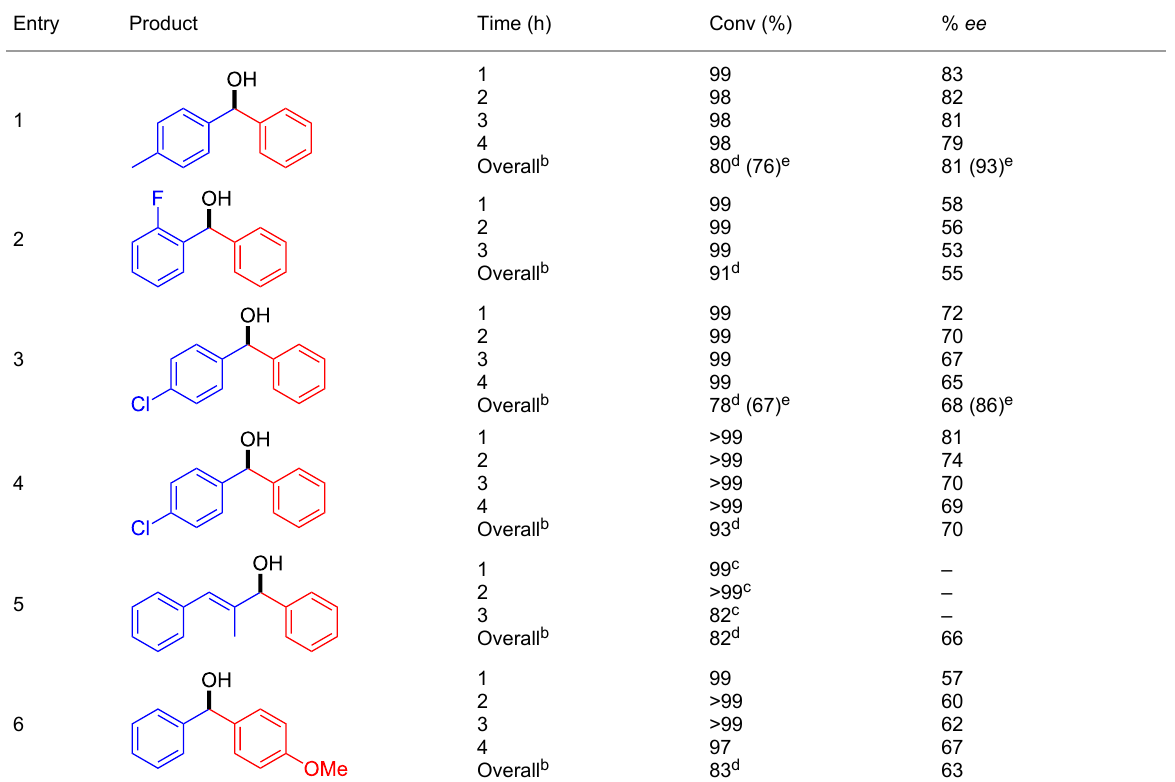
Table 3: Substrate scope in the continuous flow arylation of aldehydes. a